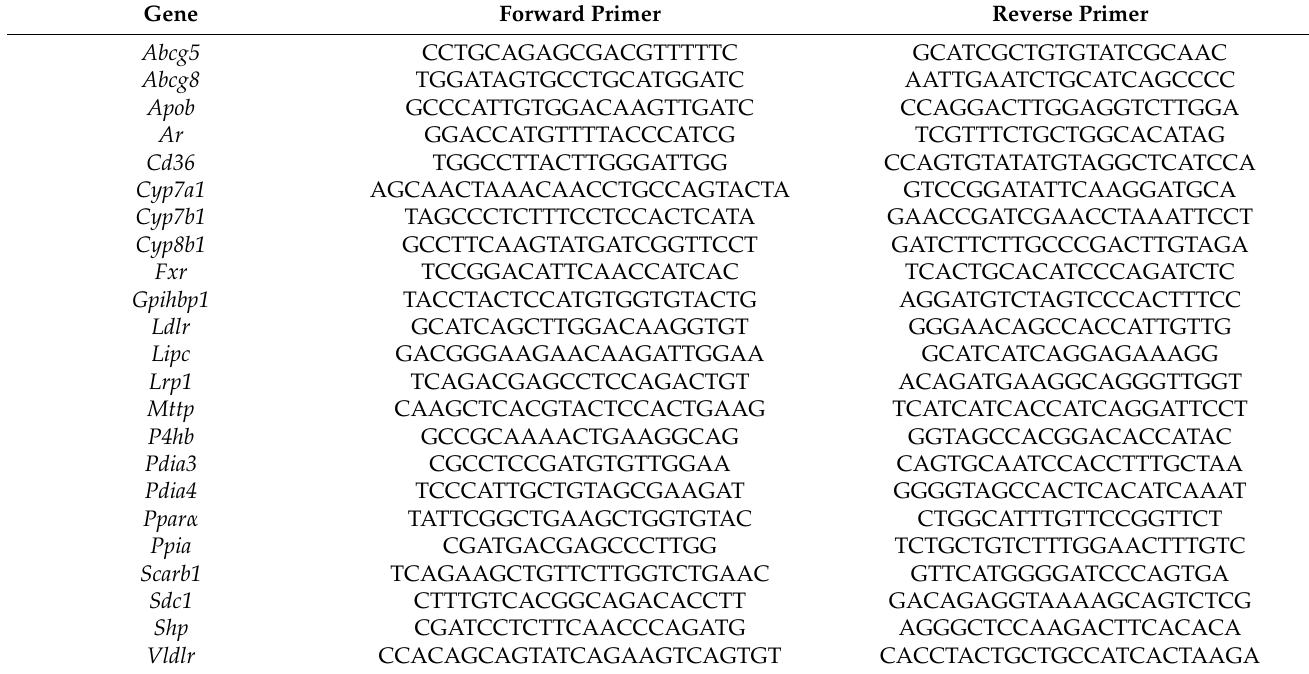
Table 1. Primer probes for